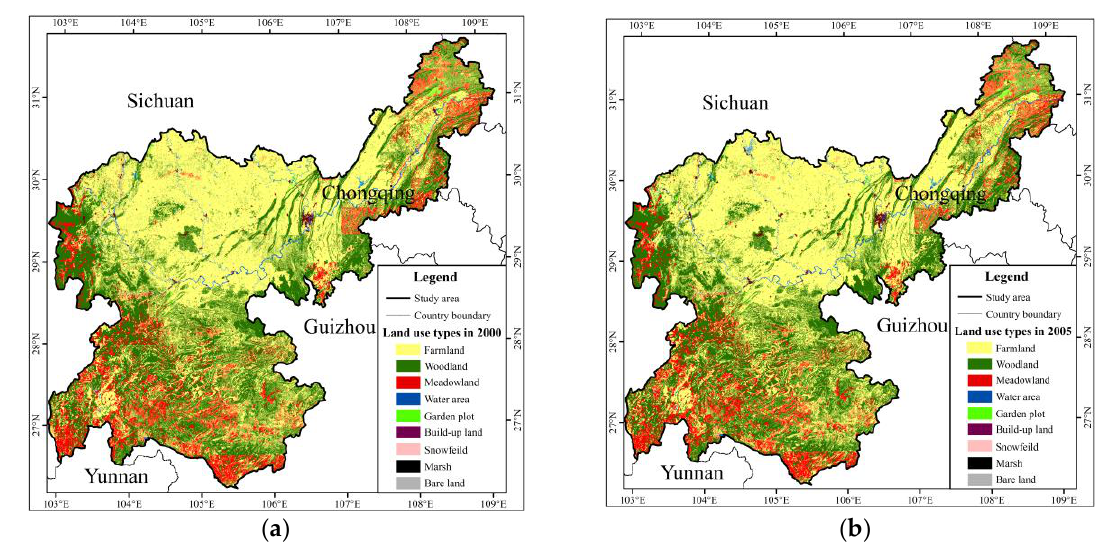
Figure 5. Land-use spatial distribution map: in 2000 ( a ); and in 2005 ( b ).